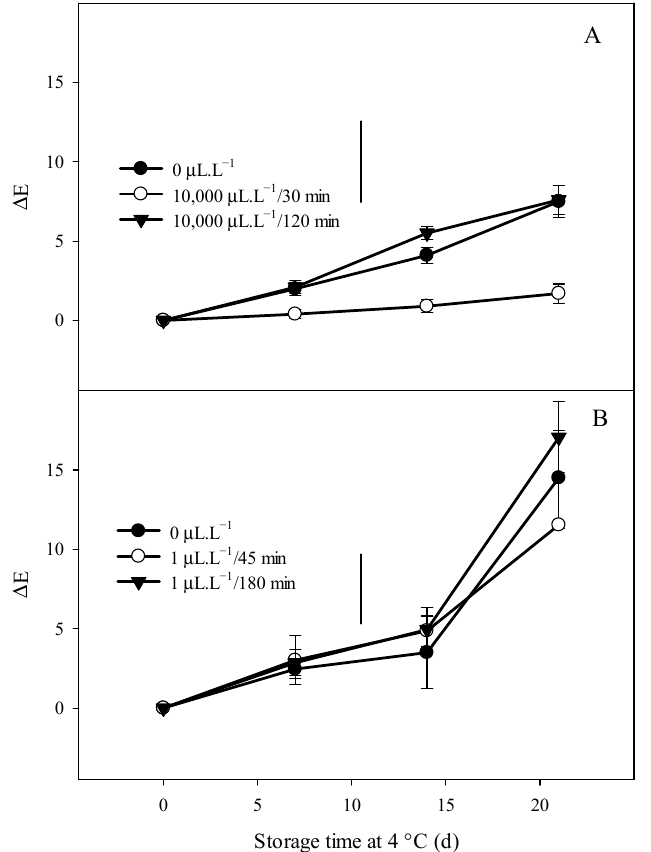
Figure 2. Evolution of total color change in broccoli florets exposed to ethanol and methyl jasmonate. Broccoli florets were treated with ethanol ( A ) at three di ff erent doses: ( ● ), control; ( ○ ), 10,000 µL.L − 1 /30 min (hormetic dose); and ( ▼ ), 10,000 µL.L − 1 /120 min (high dose). Methyl jasmonate ( B ) ( ● ), control; ( ○ ), 1 µL.L − 1 /45 min (hormetic dose); and ( ▼ ), 1 µL.L − 1 /180 min (high dose). Color change ( Δ E) was observed during 21 d of storage in darkness at 4 °C. Vertical bars represent the standard deviation of the mean (n = 9). LSD (0.05), EtOH = 4.36; LSD (0.05), MeJA = 5.09.